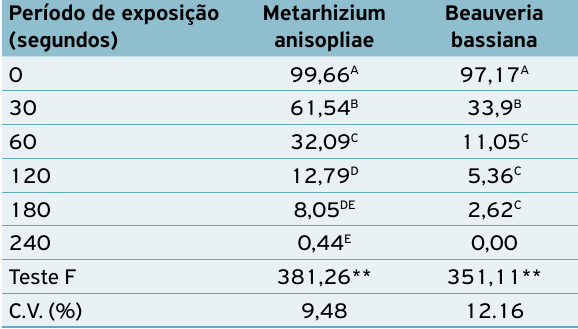
Tabela 3. Germinação (%) de conídios dos isolados de Metarhizium anisopliae e de Beauveria bassiana expostos